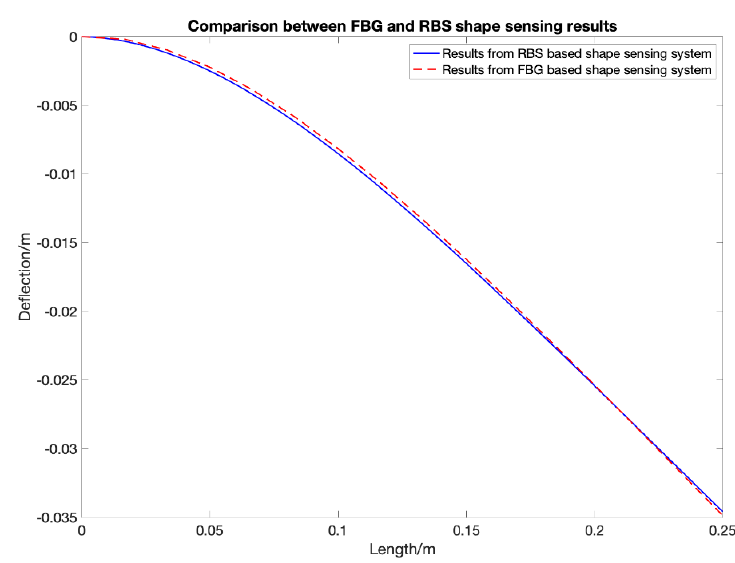
Figure 13. Comparison between fiber Bragg grating sensor and Rayleigh backscattering sensors under uniform distributed loading.